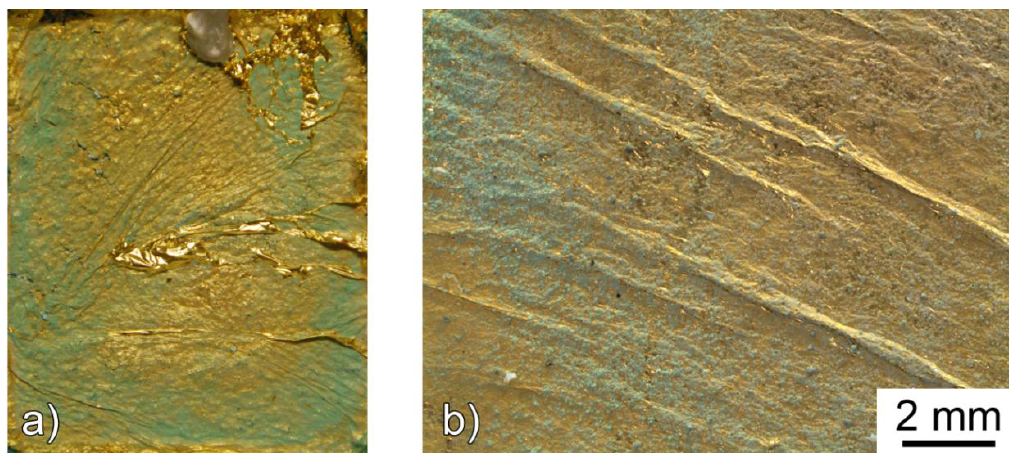
Figure 7. Macroscopic (sensor dimensions: 60  50 mm) ( a ) and microscopic ( b ) documentation of a galvanic sensors resulting from the too early application of the gold leaf on a highly moistened